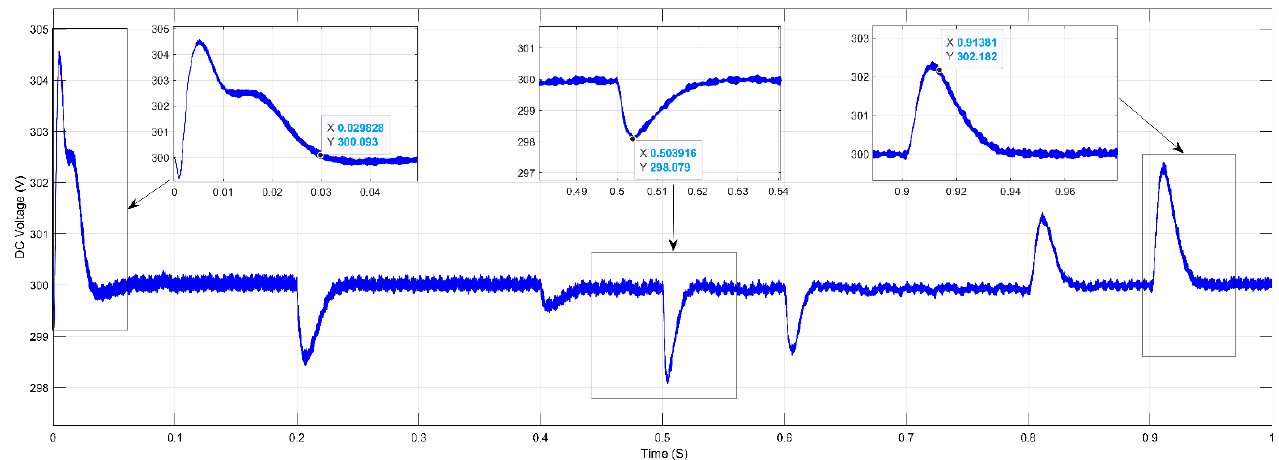
Figure 12. DC link voltage.